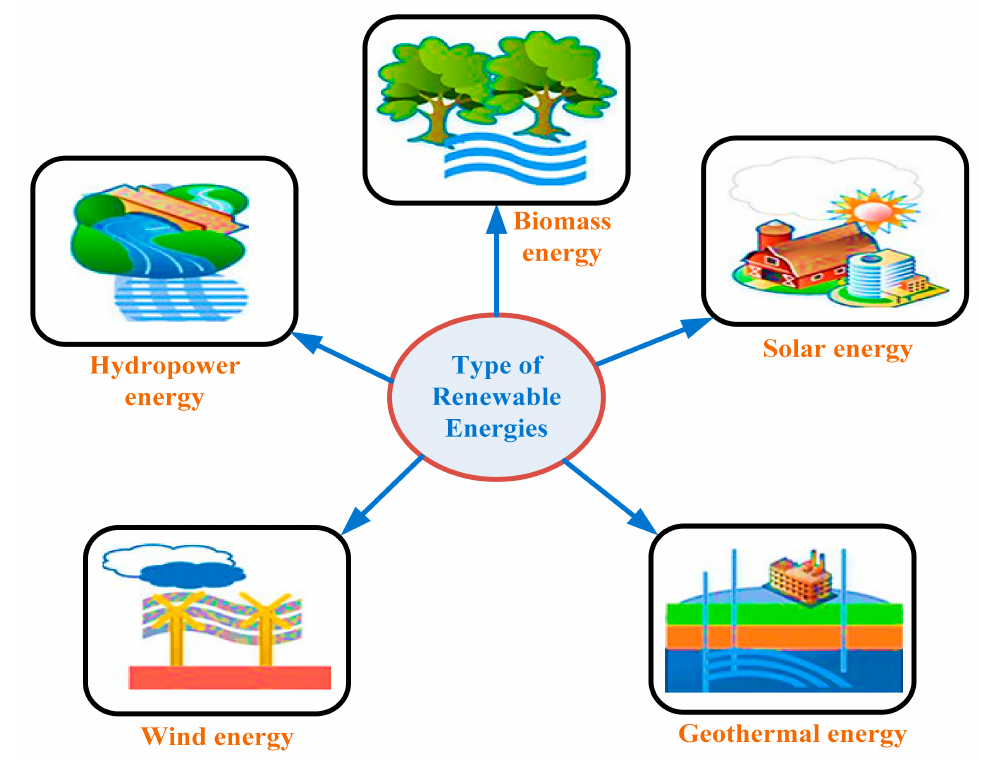
Figure 1. Renewable energy resources. Adapted from Ref.